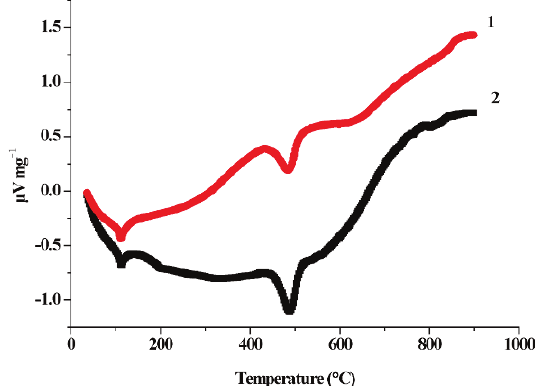
Figure 6. DTA analysis of LLDPE retardance samples 1. 70% LLDPE/10% APP/20% EG; mass percent of LLDPE, APP (I) and the EG is 70%, 10% and 20%, respectively 2. 70% LLDPE/30% EG; mass percent of LLDPE and the EG is 70% and 30%,